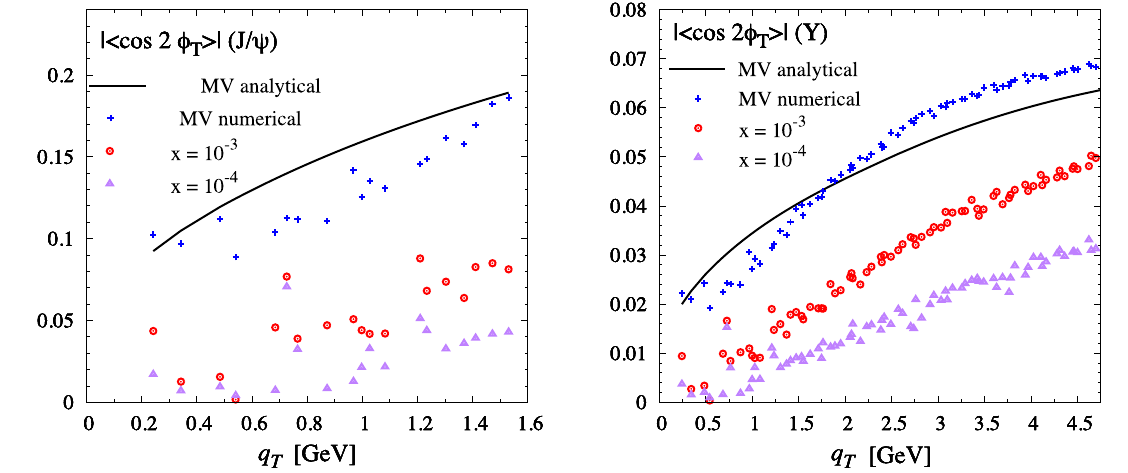
Fig. 8 (cid:2) cos2 φ T (cid:3) asymmetries as a function of q T for the processes e p → e (cid:5) J /ψ X (left panel) and e p → e (cid:5) ϒ X (right panel), calculated at Q = M Q and y = 0 . 1, and using the CMSWZ set for the J /ψ LDMEs given in Table 1